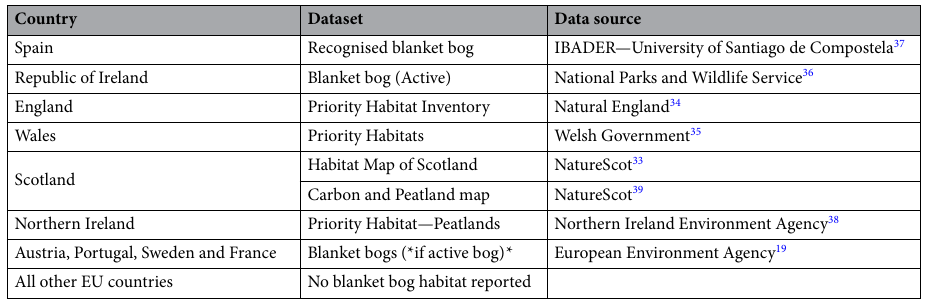
Table 4. Data source for each blanket bog area by country. *For Austria, Portugal, Sweden and France, there is no specific dataset for blanket bog areas when the study was completed. The total extent of Nature 2000 sites where blanket bog has been reported were assessed to determine if windfarm infrastructures were present on the